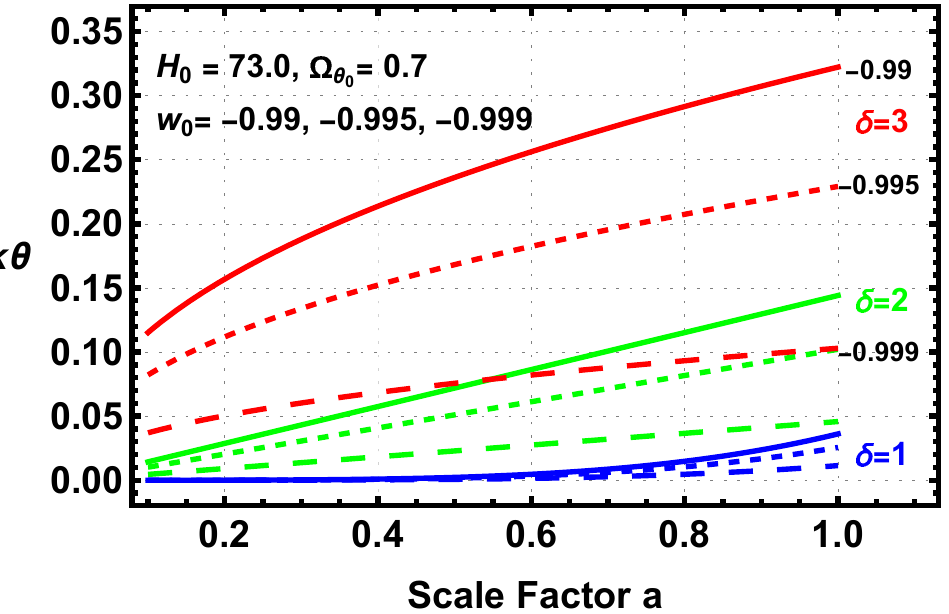
Figure 4. The figure plots the evolution of the scalar for all of the δ and w 0 values in this study. The w 0 values for the δ = 3 case are labeled on the plot. The order and line styles are the same for the other two δ values. The evolution is relatively small consistent with a slow roll. As expected the scalar values are monotonically increasing. The most striking feature is that the second derivative of the evolution changes from positive for δ = 1 to almost zero for δ = 2 to negative for δ = 3. The three, seemingly arbitrary, delta values were chosen to illustrate this transition. The transition has a large effect on some parameters, such as the dark energy EoS, w , but relatively little effect on the Hubble parameter as is shown later in Figure